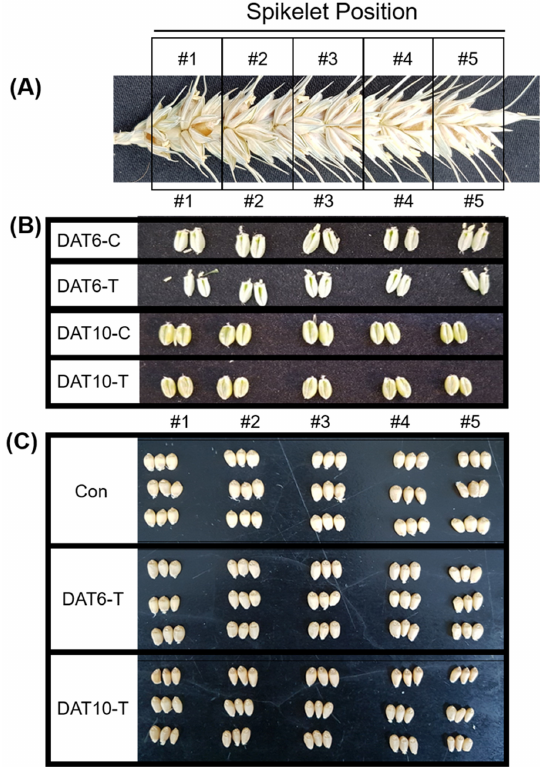
Figure 1. Spikelet position and seeds collected from spikes under high-temperature stress. ( A ) Division of a spike from base to top (spikelet #1–5). ( B ) Seeds taken from the five different sections of the spike. ( C ) Seeds from mature plants collected from the five different spike sections. Con, nontreated; DAT6-T, 6 days of treatment; DAT6-C, 6 days of nontreated control; DAT10-T, 10 days of treatment; DAT10-C, 10 days of nontreated control.